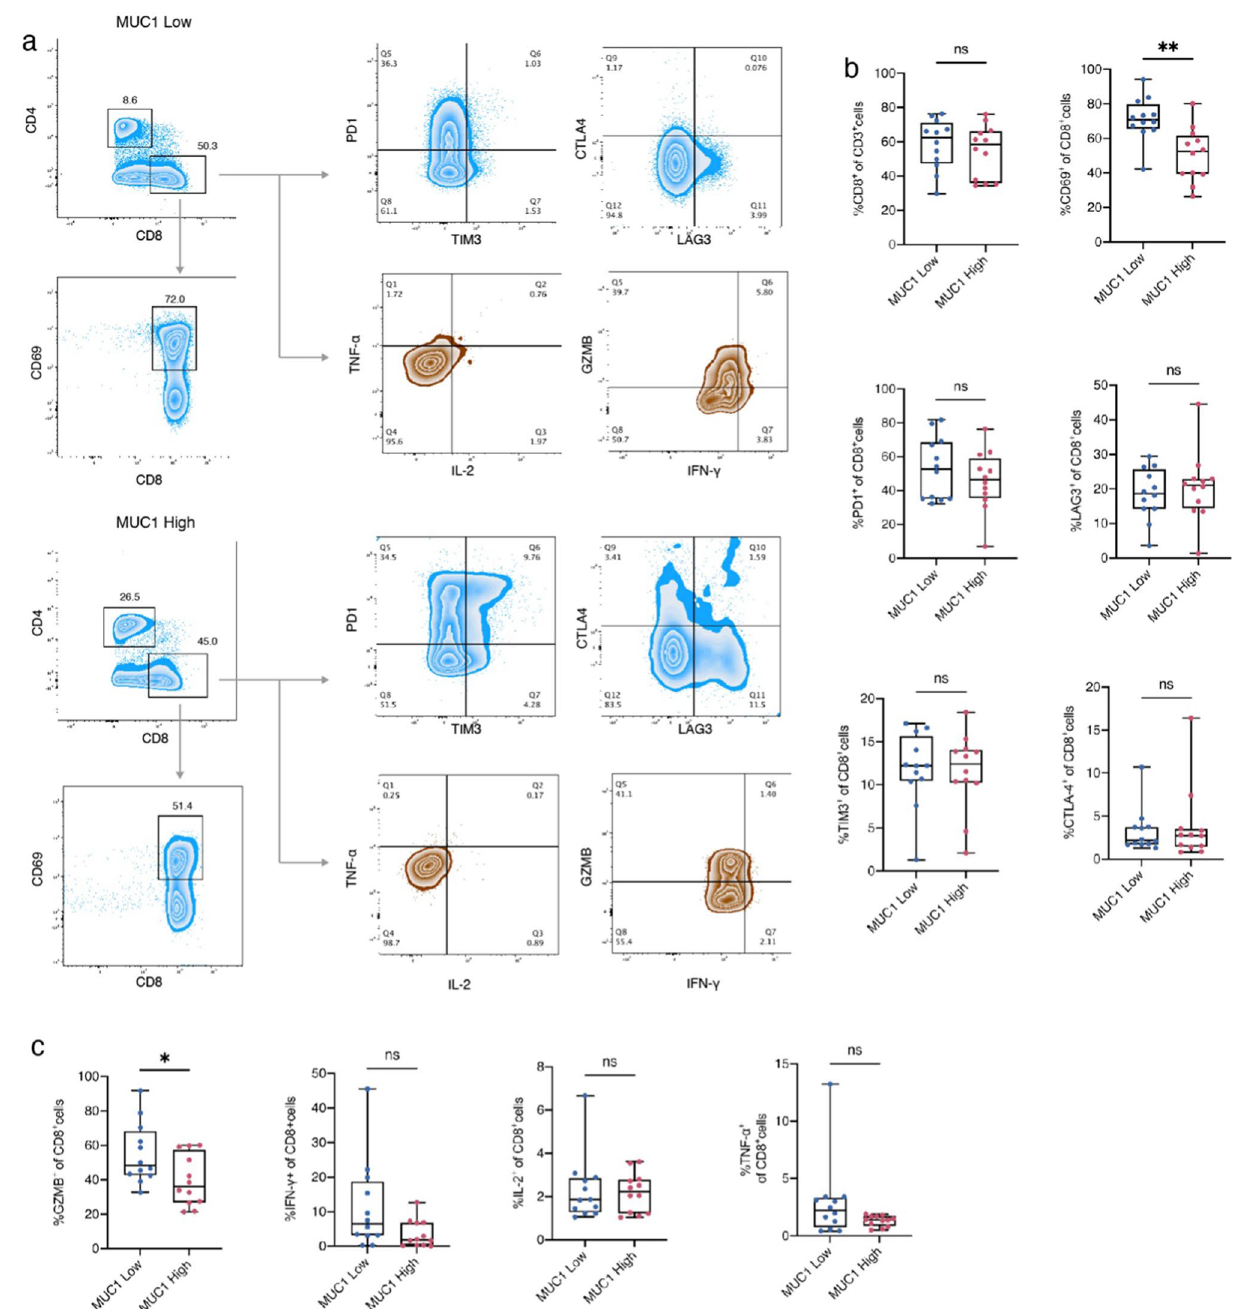
Fig. 6 Association between MUC1 expression and CD8+T cell function and immune checkpoints. a Representative flow cytometry charts of CD8+T cell function and immune checkpoints based on MUC1 expression. b Statistical map of CD8+T cell immune checkpoints. c Statistical map of CD8+T cell function. *P < 0.05, **P < 0.01, ***P < 0.001, by two-tailed unpaired t test ( b , c